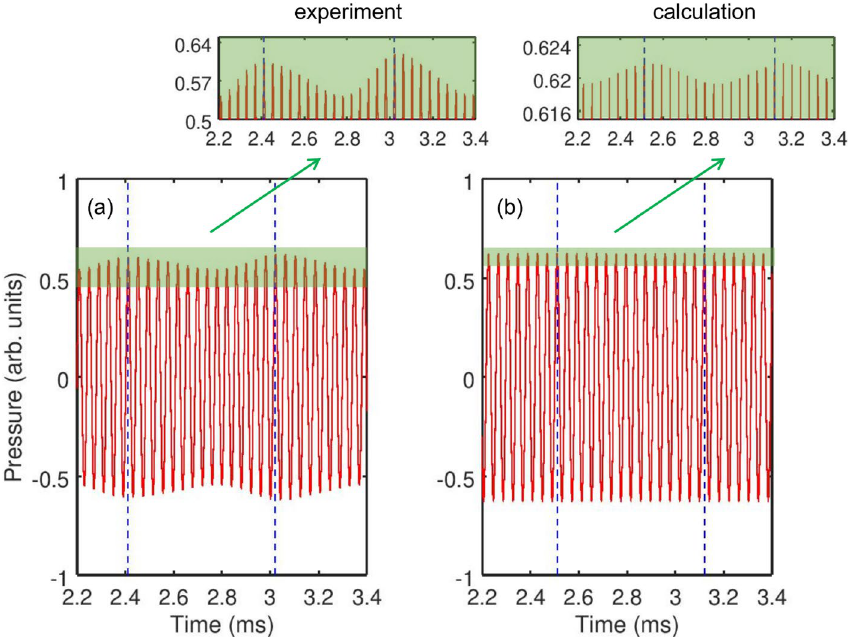
Figure 3. ( a ) Measured acoustic response of the gas bubble cluster and ( b ) calculated acoustic response of a single equivalent bubble corresponding to a sinusoidal pressure wave with the frequency f 0 11.5 kPa. In the calculation, the initial conditions were set to be R ( 0 ) amplitude α = Eq. (1). The time between the vertical dashed lines is � T waveforms and demonstrate the amplitude modulation (see the main text for more details.) Arbitrary pressure units are used in both panels to enable the comparison of the experimental and calculated